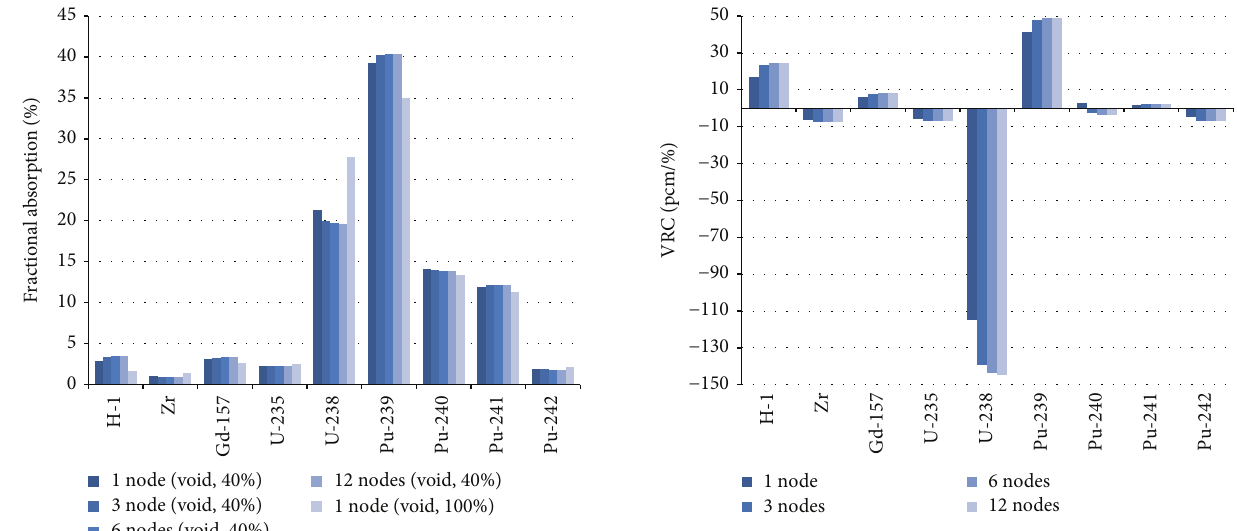
Figure 8: Decomposition of VRC values to values of separate